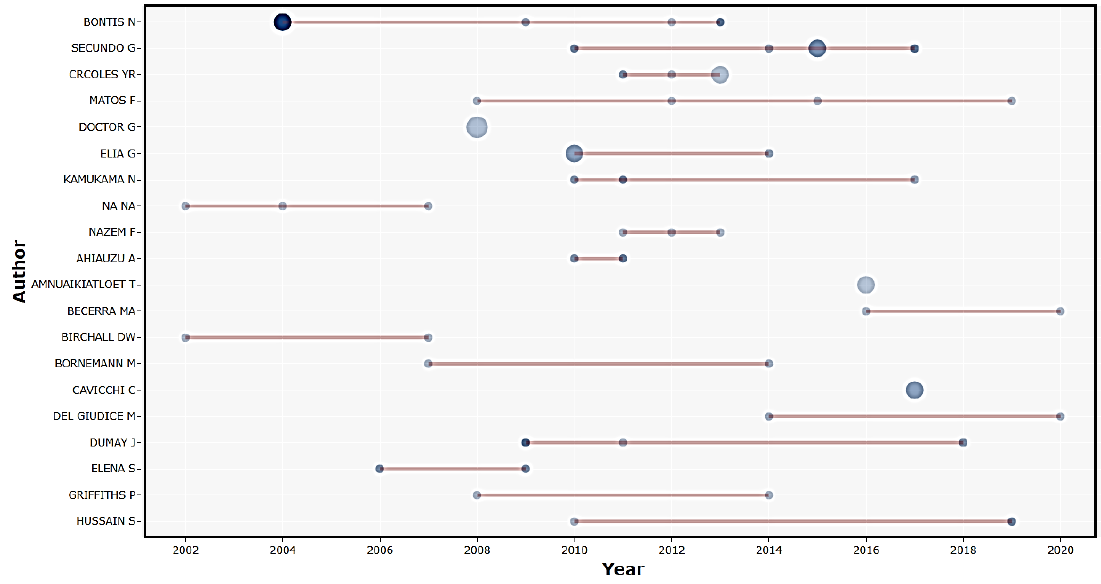
Figure 11. Time evolution of the 20 top authors in intellectual capital.